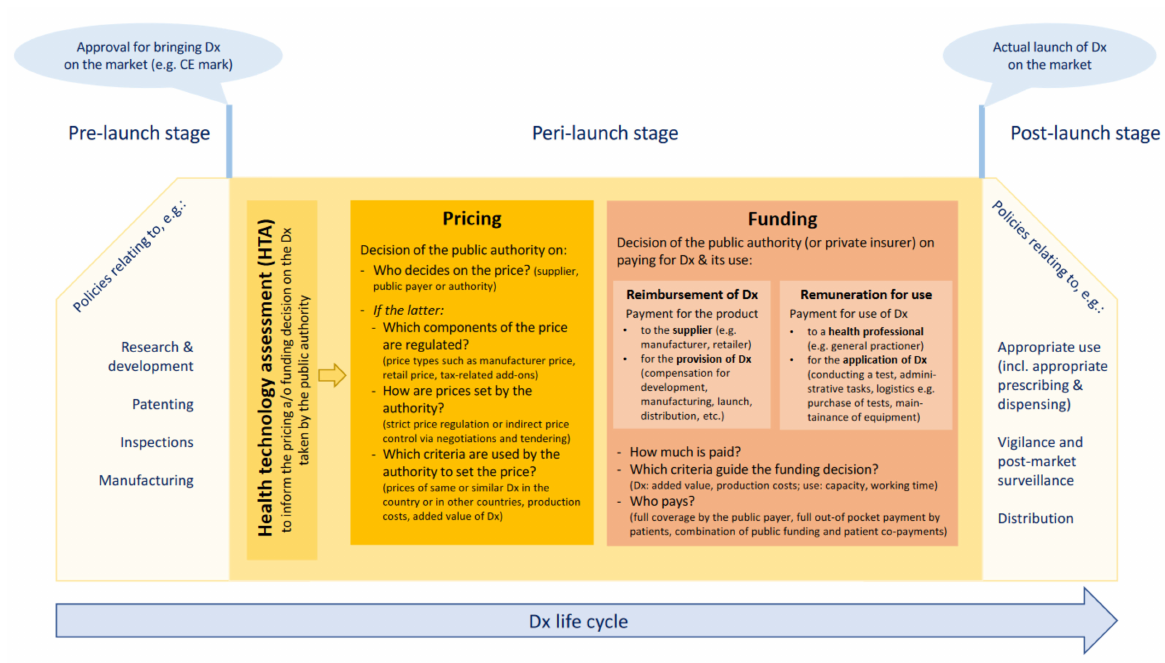
Figure 1. Framework for studied pricing and funding policies. Source: Authors. CE: Conformit é Europ é enne/European Conformity; Dx: